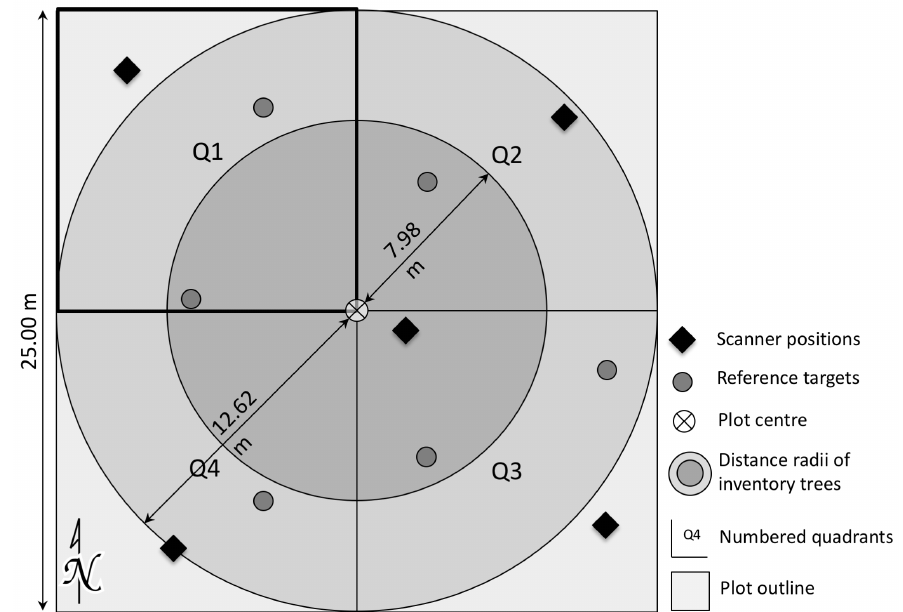
Figure 1. Schematic composition of a sample plot for terrestrial laser scanning and reference data collection. The square shaped plots had an edge length of 25 m and were centred on the original inventory points. The two concentric circles indicate the distances for mature tree data collection by the forest inventory. The plots were split into four quadrants for processing, whereof the first quadrants (Q1) were used for 3D validation (marked with bold outline). Scanner positions and reference targets were distributed over the plot to minimize occlusion